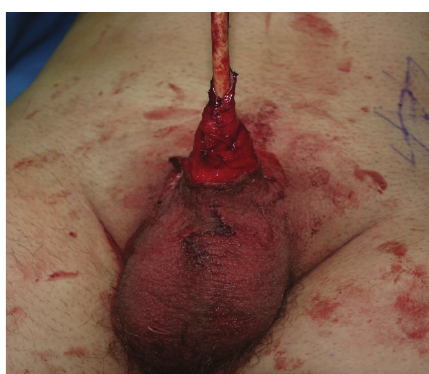
Figure 2: Dorsal and ventral Z plasties done.